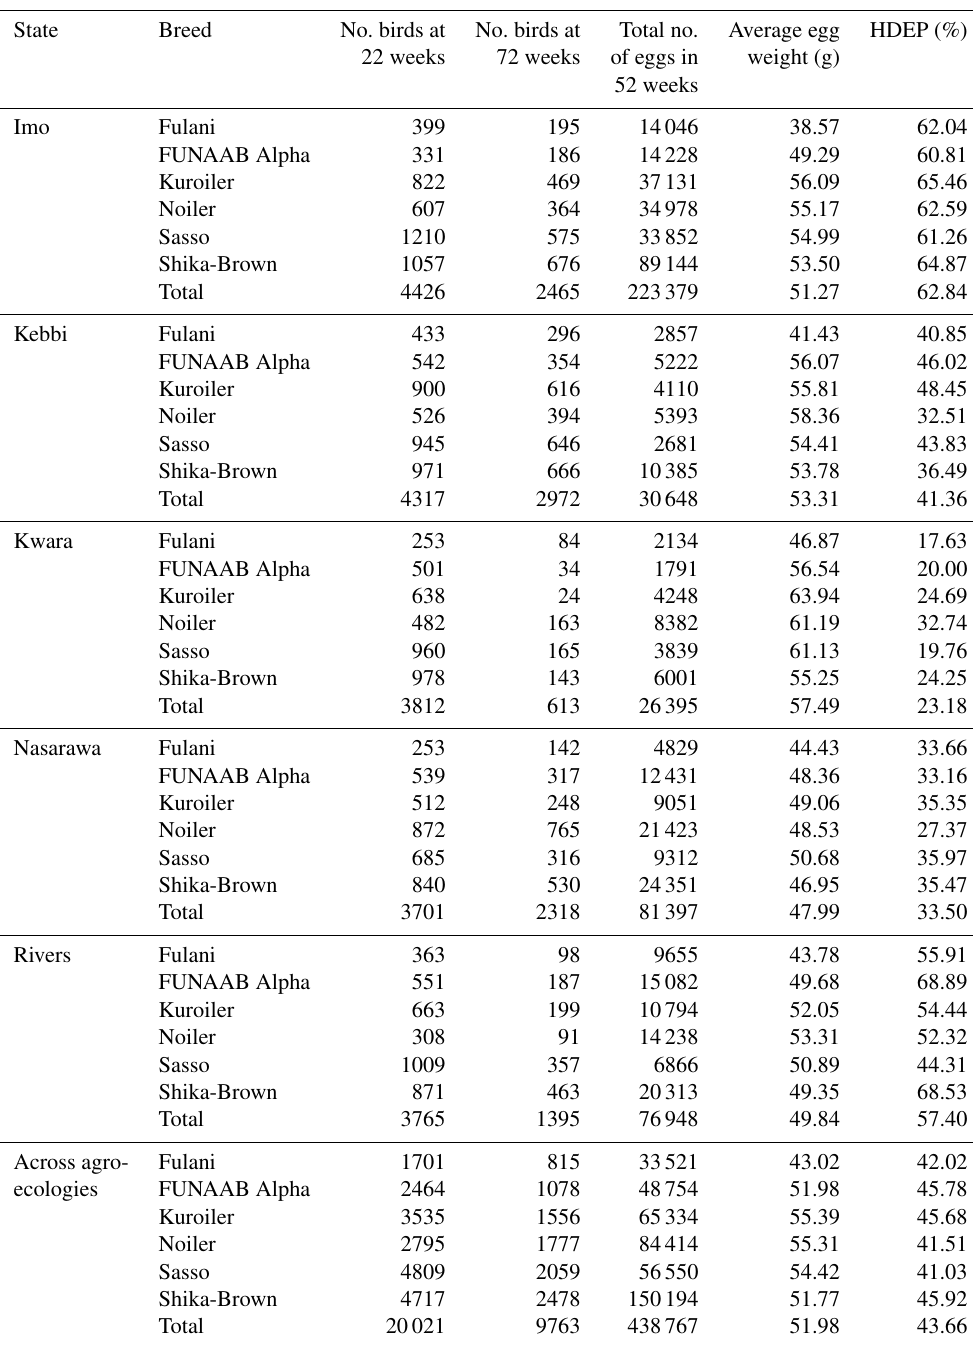
Table 7. Total egg production per breed and by location in ACGG Nigeria project zones (2016–2018).